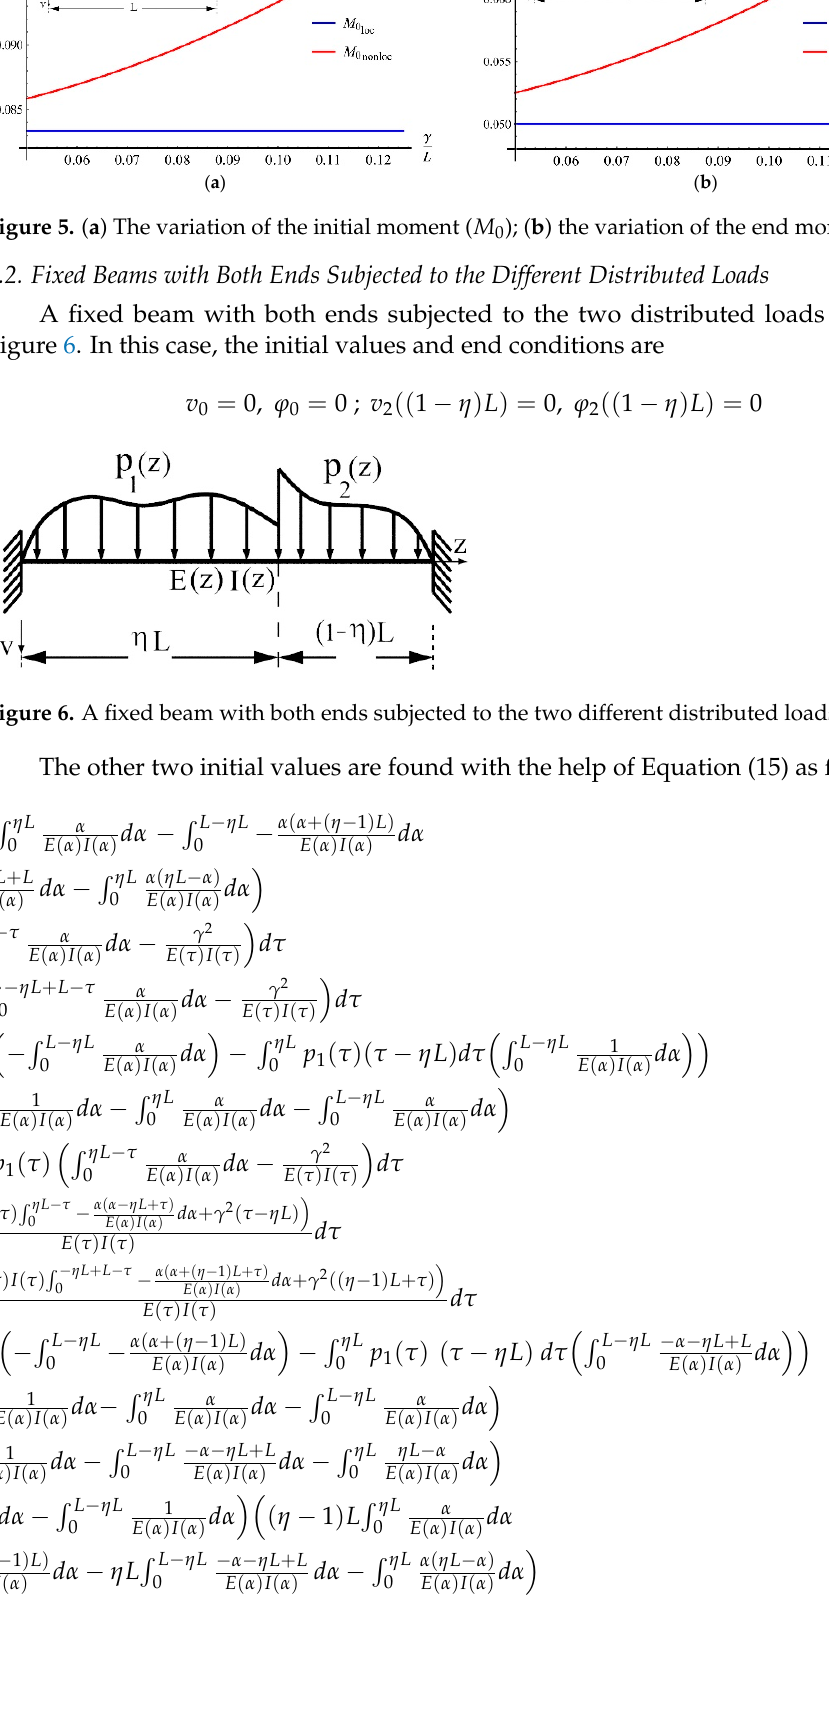
The end moments are found using Equation (8) as below.